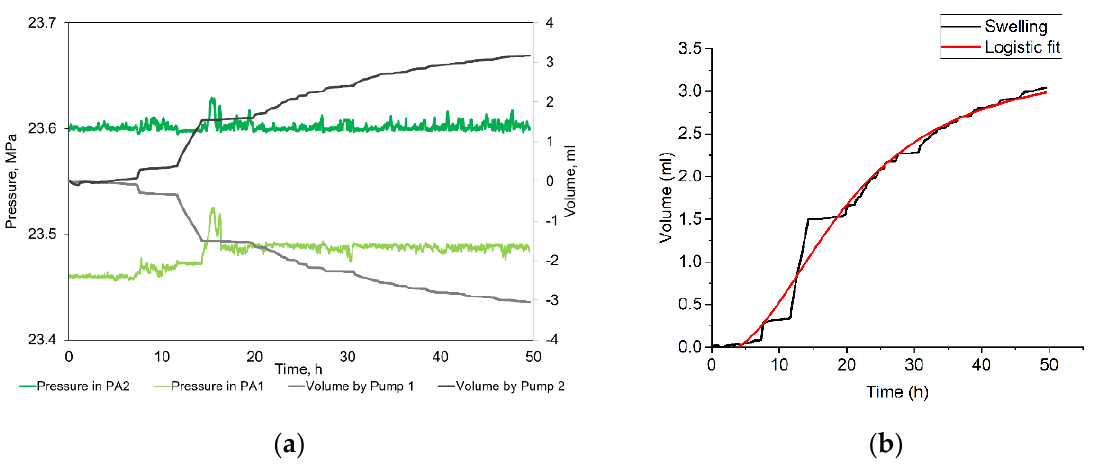
Figure 3. Results of the bentonite swelling in the presence of 0.2% wt. NaOH. ( a ) Measured experi- mental dependencies. ( b ) Measured sample rock volume change (black) and approximation with logistic function (red) with parameters A 2 = 3.37, A 1 = − 0.01, x 0 = 19.77, p = 2.25 (see Equation (6)).